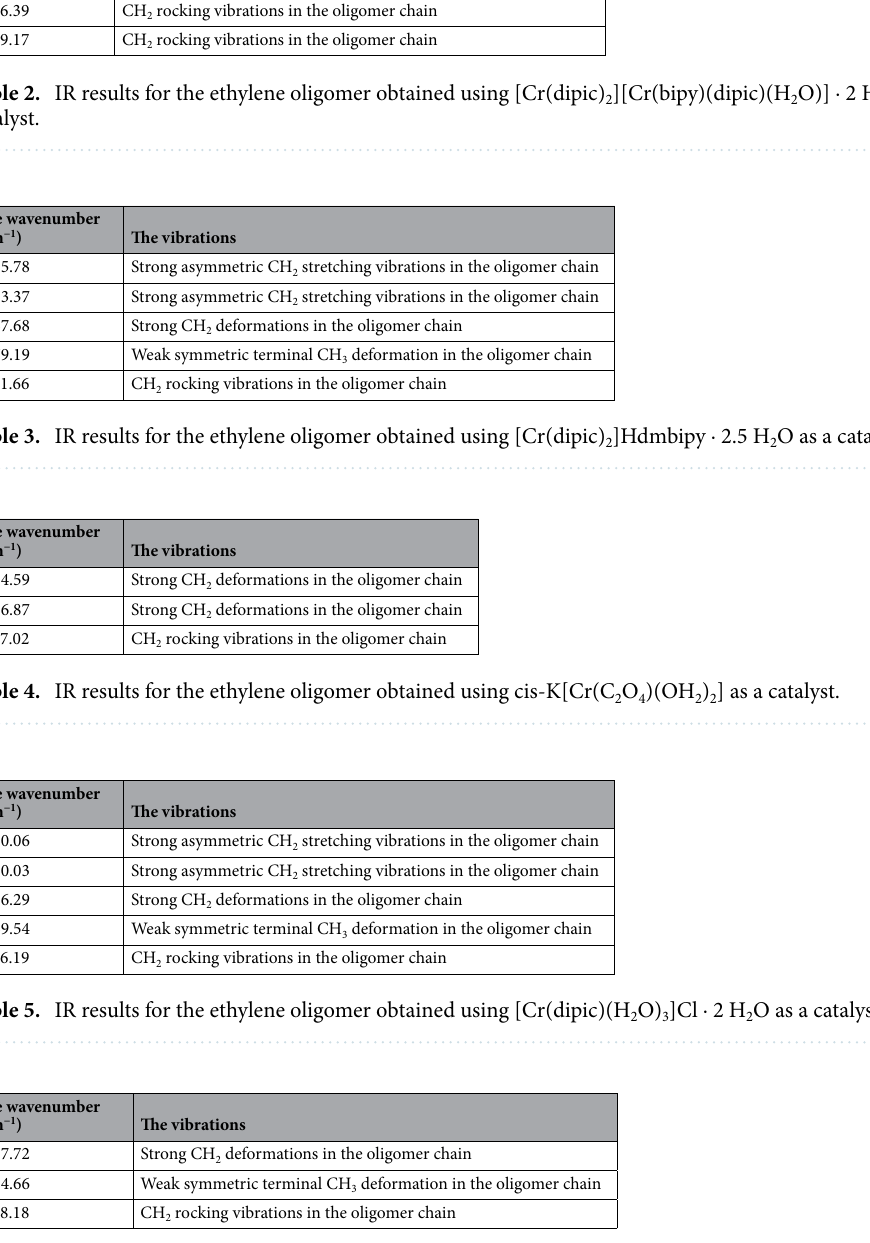
Table 6. IR results for the ethylene oligomer obtained using 3 (C 18 H 15 CrN 6 O 6 ) ∙ CHCl 3 ∙ 5 H 2 O as a catalyst.